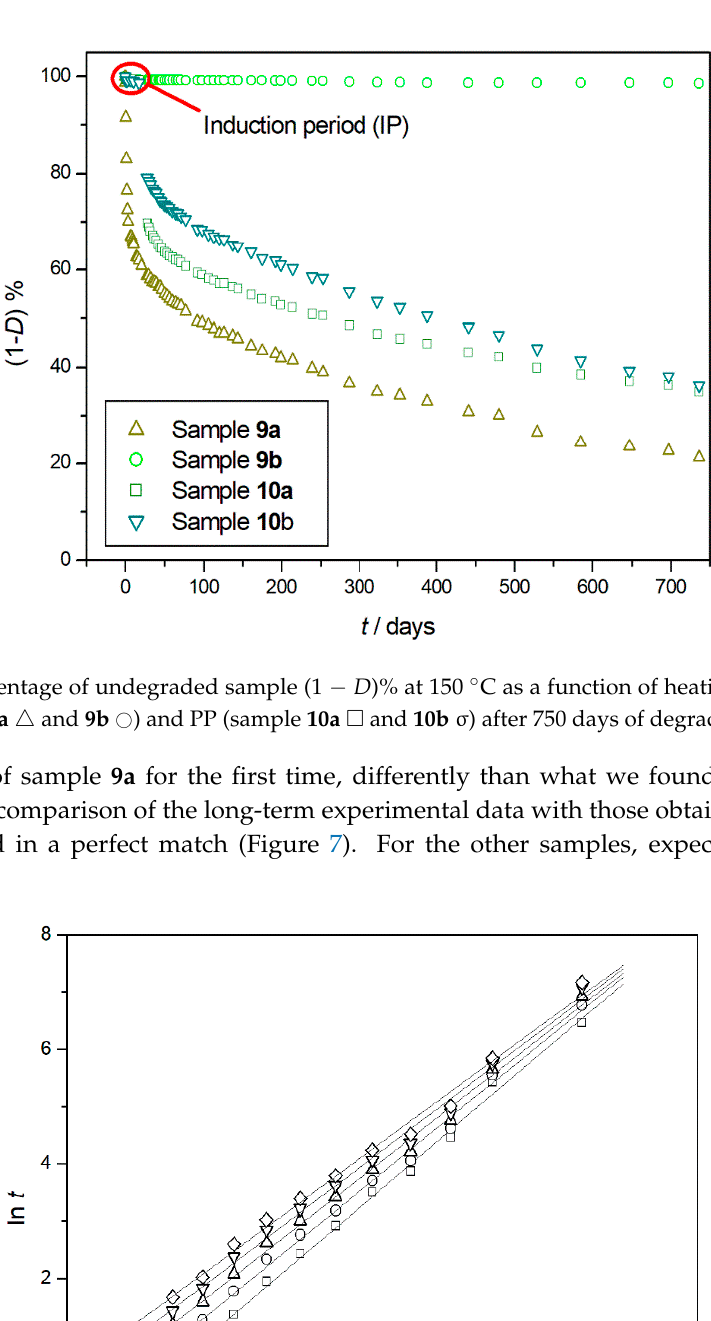
), 10% ( (cid:52) ), 12.5% ( σ ), and (cid:35)